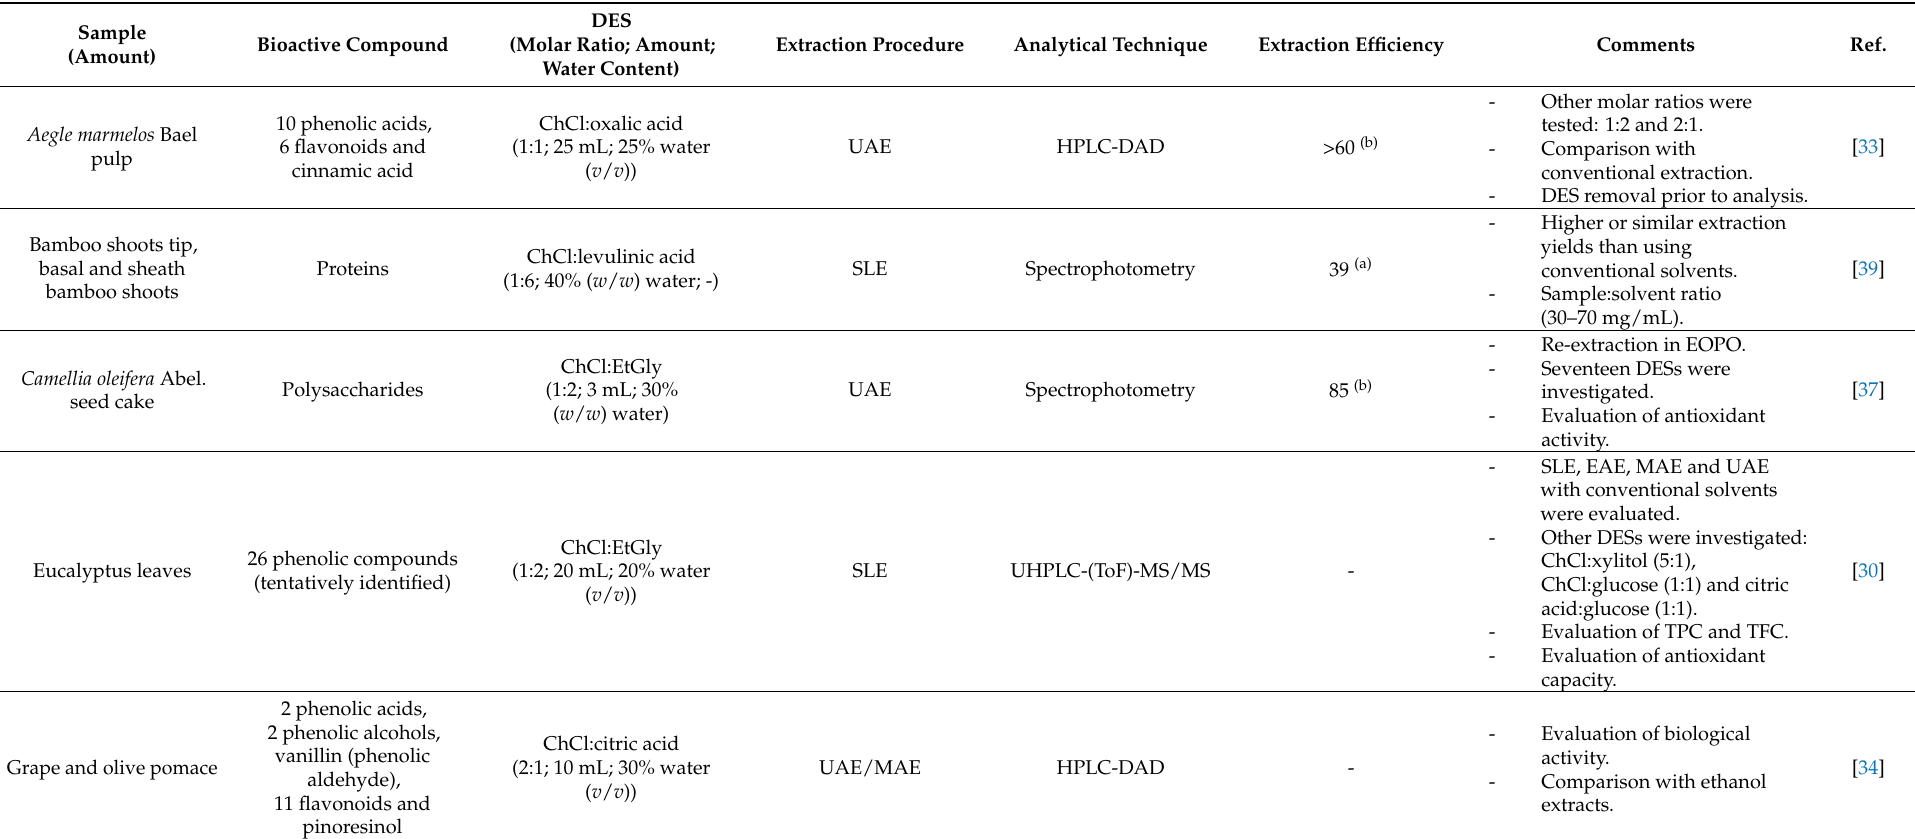
Table 2. Some examples of recent applications of DESs for the extraction of bioactive compounds from agricultural and food industry